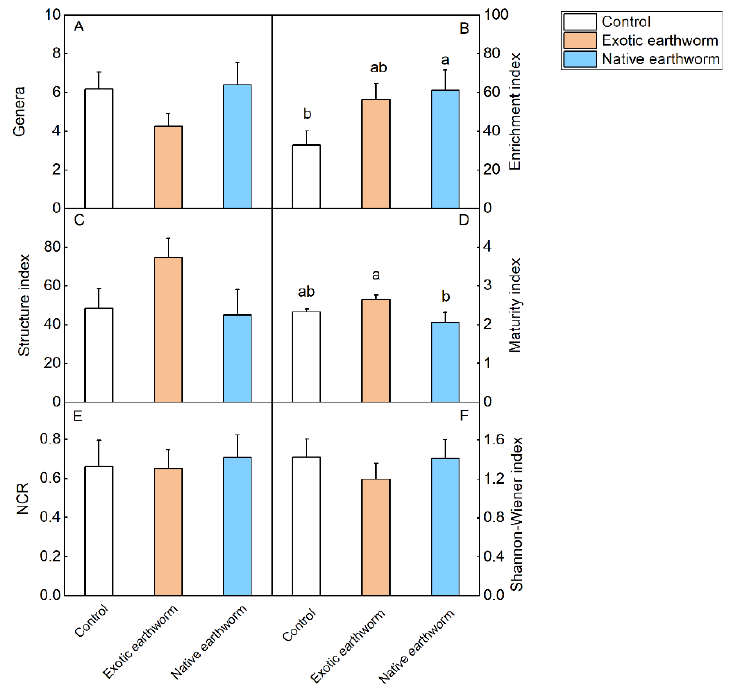
Figure 4. Nematode community indices as affected by the presence of exotic and native earthworms. Genera: number of genera per sample ( A ); enrichment index ( B ); structure index ( C ); maturity index ( D ); NCR: nematode channel ratio ( E ); Shannon–Wiener index ( F ). Data represent means + standard error (n = 5). Significant ( p < 0.05) effects based on one-way ANOVA (Table S6) are presented by different letters above each column. No letters means there was no